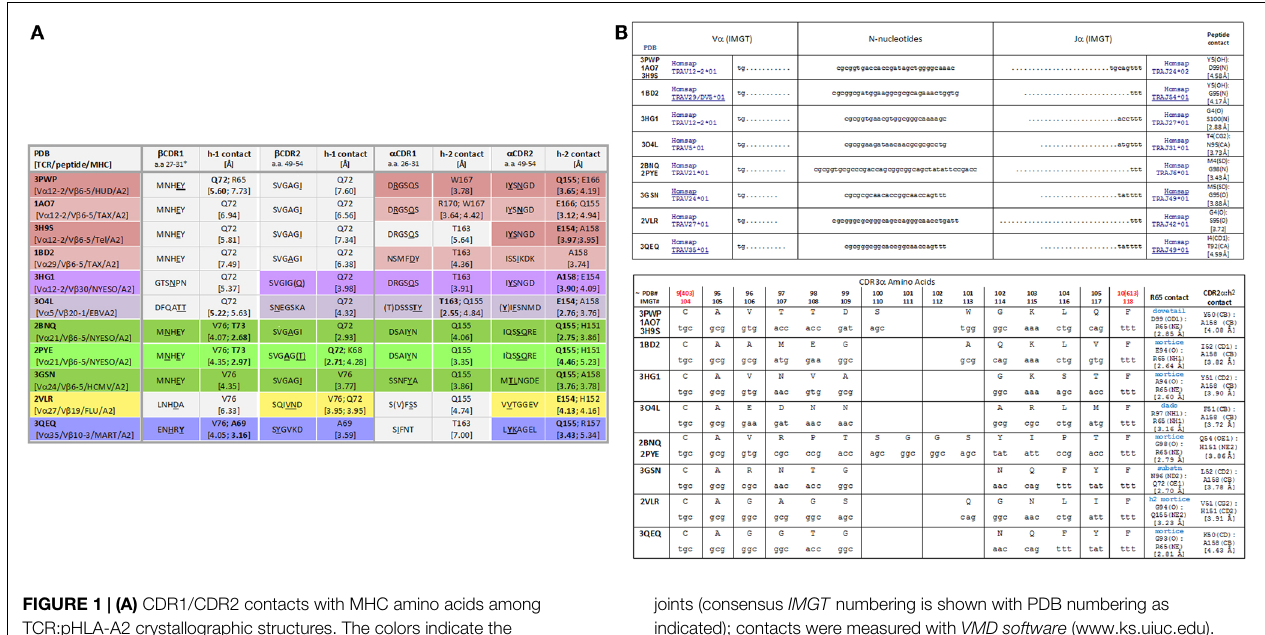
FIGURE 1 | (A) CDR1/CDR2 contacts with MHC amino acids among TCR:pHLA-A2 crystallographic structures. The colors indicate the alpha-dominant (rose shades), alpha/beta (lavender, green, and yellow), and beta-dominant (blue) modes of binding. [ (B) , top ] nucleotide sequences for all CDR3 α of TCR in the indicated PDB files. TCRA were reverse translated then subjected to joint analysis. [ (B) , bottom ] CDR3 α